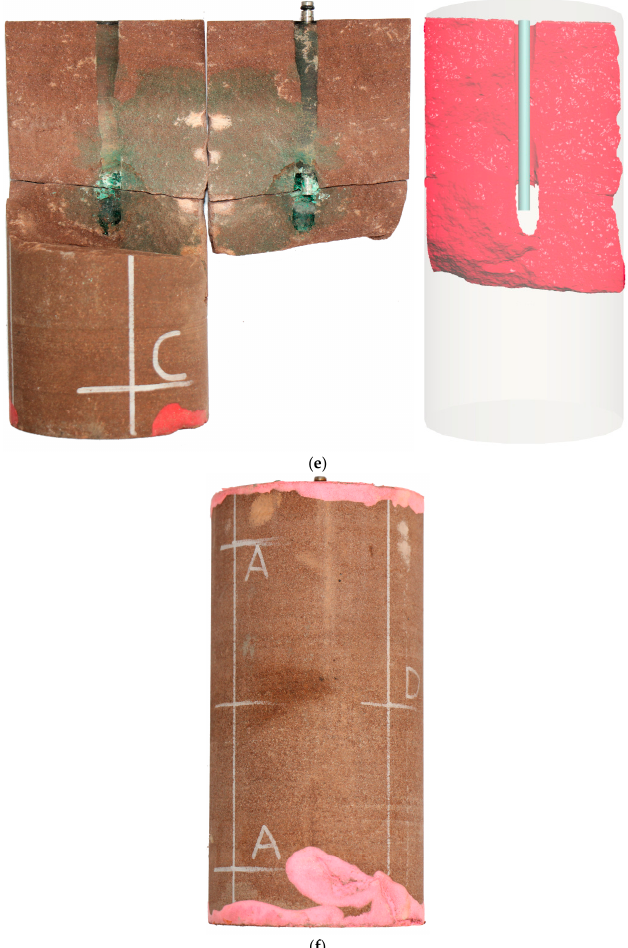
Figure 13. Post-fractured view and scanning reconstruction of hydraulic fracture morphology of cyclic hydraulic fracturing samples: ( a ) S5, ( b ) S6, ( c ) S7-1, ( d ) S10, ( e ) S13-1, ( f ) S14-1. To sum up, conventional hydraulic fracturing can only form a single transverse frac- ture. In addition to forming a single transverse or longitudinal fracture, cyclic hydraulic fracturing can also form complex and diverse fractures in which transverse and longitu- dinal fractures exist simultaneously. Even if a similar horizontal fracture is formed, the